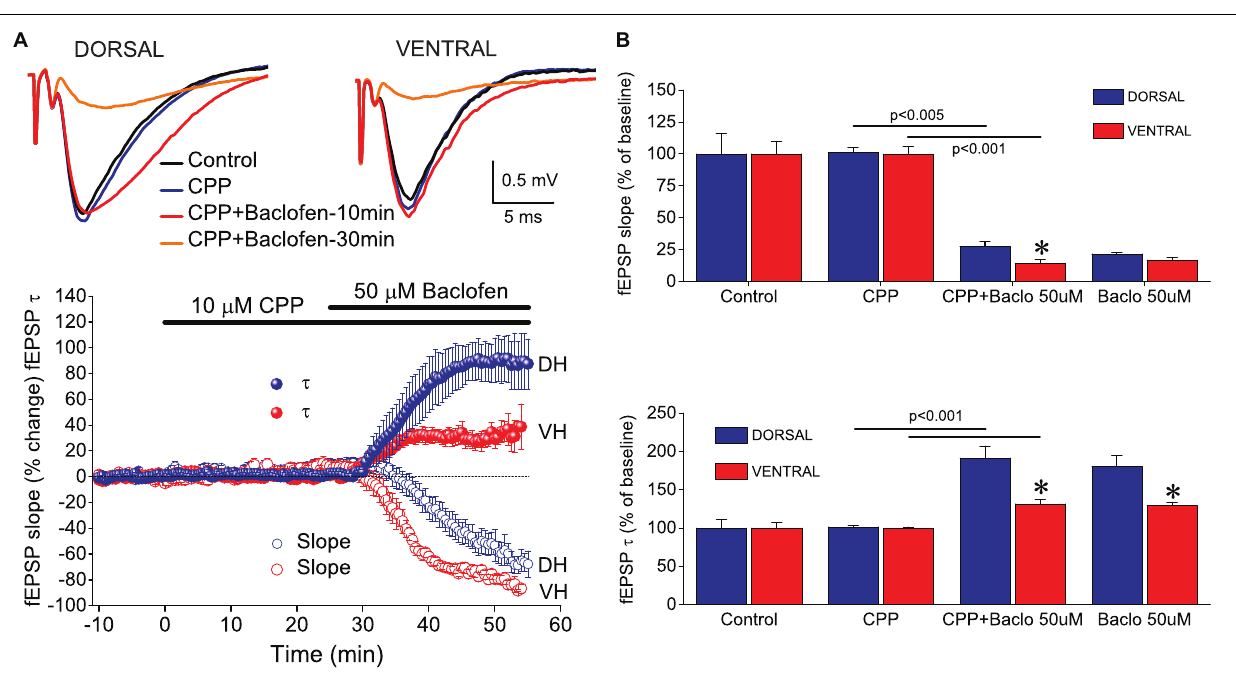
FIGURE 8 | NMDA receptors are not involved in baclofen-induced effects on fEPSP. (A) Example traces of fEPSP recordings (upper panel) and time-courses (graph on the bottom) of percent changes in fEPSP slope and fEPSP τ induced by 50 µ M baclofen under blockade of NMDA receptors by CPP. (B) Cumulative data obtained during application of CPP (25 min) and CPP + baclofen (30 min) are shown for fEPSP τ and fEPSP slope (upper and lower graph, respectively). Statistically significant differences between experimental conditions are shown by horizontal lines and the level of significance is given above lines. Asterisks indicate statistically significant differences between the dorsal and the ventral hippocampus, at p < 0.05. CPP did not prevent the effects of baclofen on fEPSP τ or fEPSP slope in either hippocampal segment.